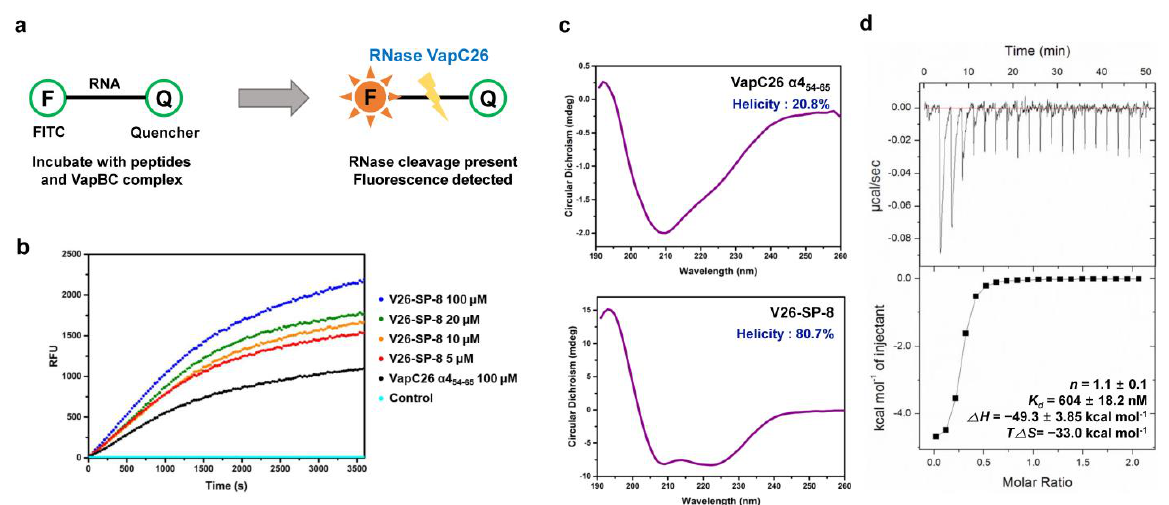
Figure 2. In vitro assay data for stapled peptides. ( a ) Schematic diagram of the in vitro ribonuclease activity assay. ( b ) In vitro ribonuclease activity assays of V26-SP-8 and VapC26 α4 54–65 . The data shown are representative of three independent experiments. ( c ) CD spectra of VapC26 α4 54–65 and V26-SP-8 . The data shown are the averages of three independent scans. ( d ) ITC assay of the interaction between V26-SP-8 and VapB26. Similar results were obtained in two independent experiments.